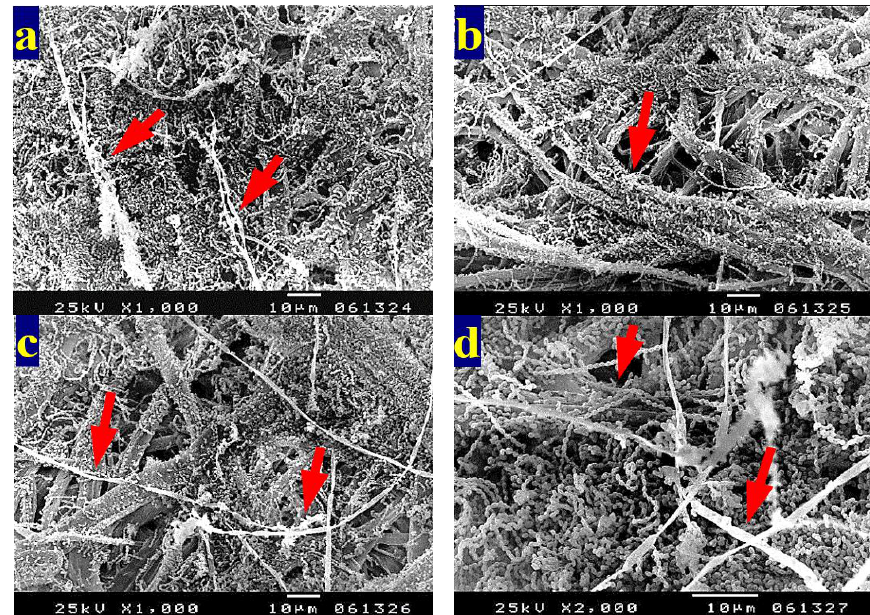
Figure 4. SEM images of E. camaldulensis WB pulp paper manufactured with HeOE additives and inoculated with A. terreus : ( a ) with M. azedarach oil at 1%, where arrows indicate a dense fungal spores and mycelia covering the surface of the fibers; ( b ) with S. alba at 1%, where arrow refers to huge fungal spores encapsulates the fibers, and ( c , d ) with M. grandiflora oil at 1%, where arrows refer to dense growth of fungal mycelia and spores that covers the entire surface of the sample almost